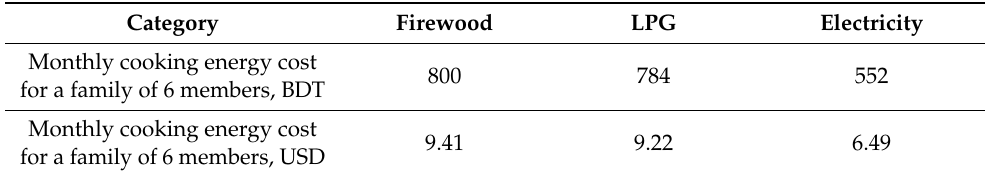
Table 7. Comparative cost of cooking using different